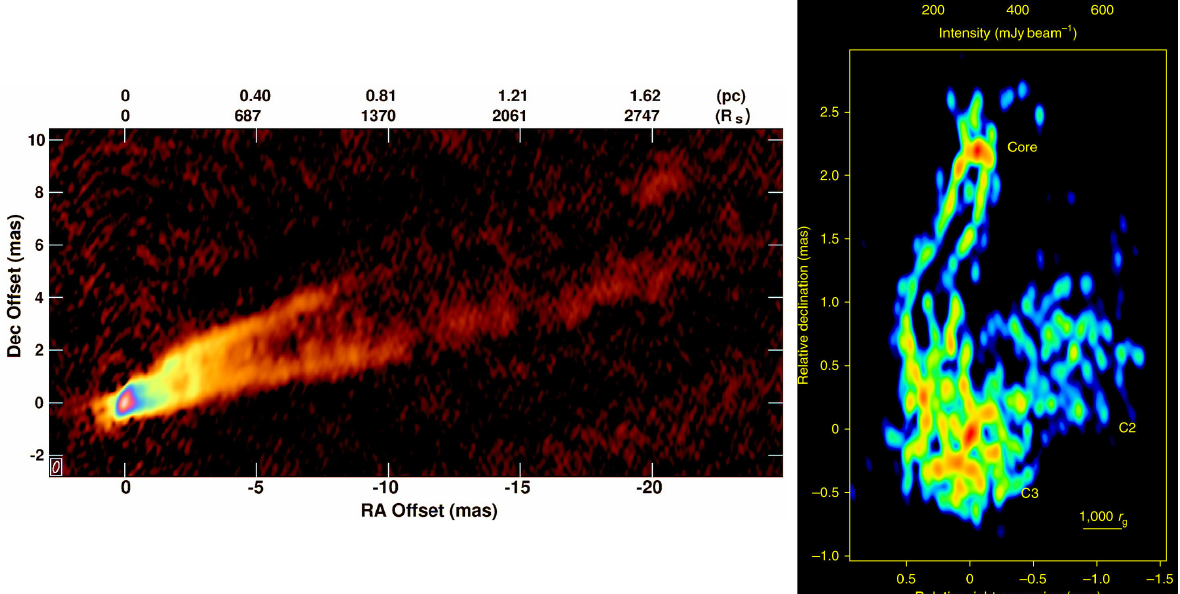
Figure 8. Two examples of AGN jets displaying prominent limb brightening: M87 ( left , reprinted with permission from [60]; copyright 2018 American Astronomical Society) and 3C84 ( right , reproduced with permission from